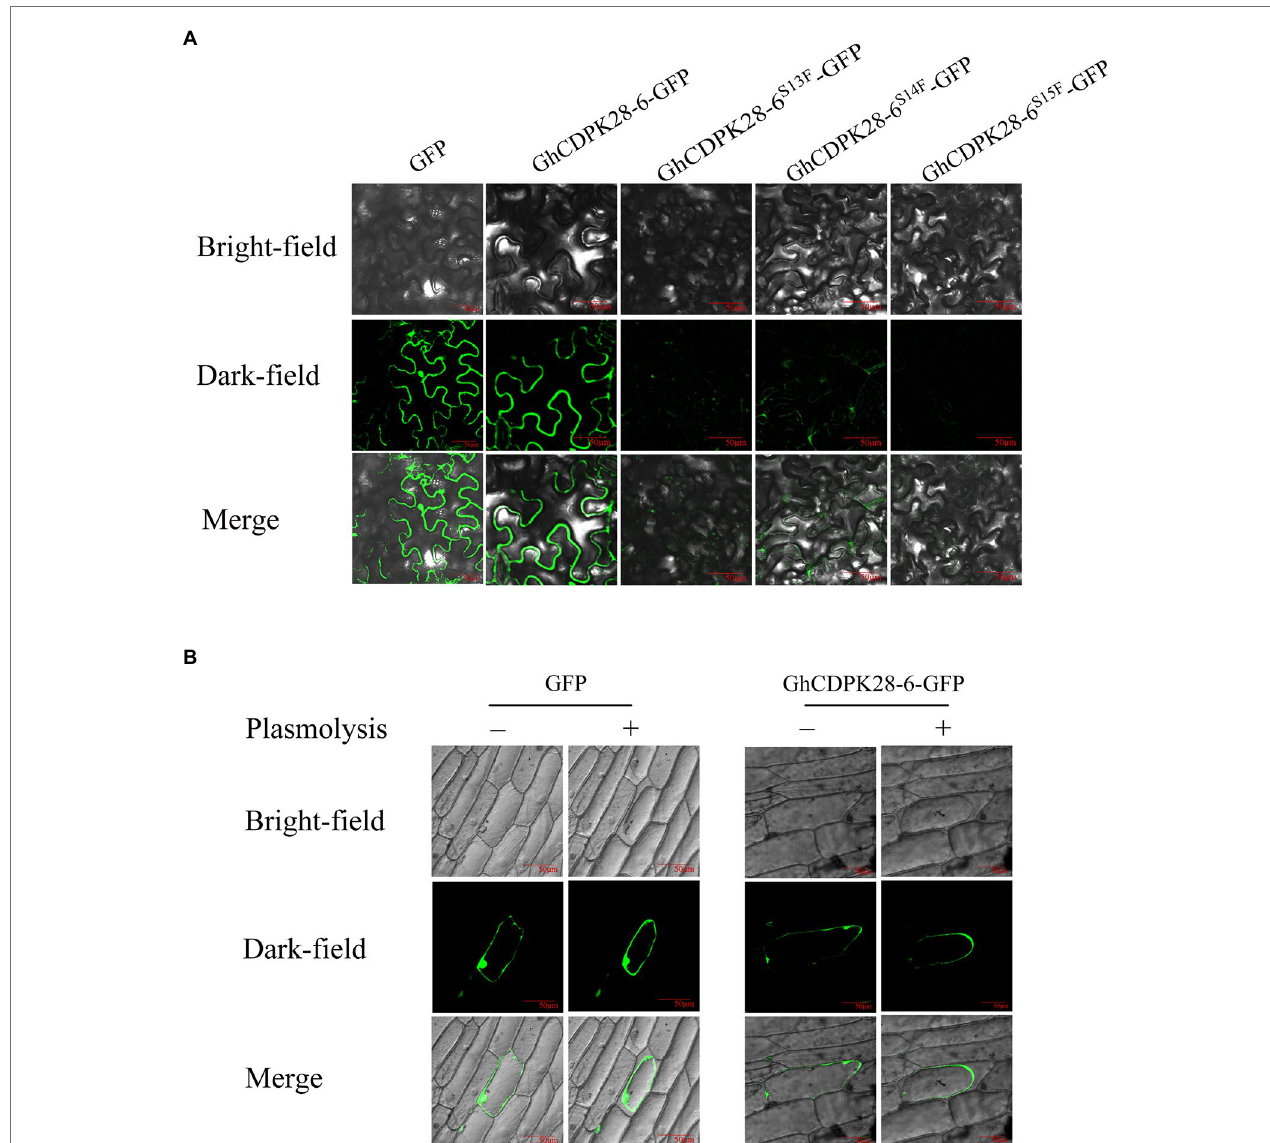
FIGURE 9 | Subcellular localization of GhCDPK28-6, GhCDPK28-6 S13F , GhCDPK28-6 S14F and GhCDPK28-6 S15F . (A) Subcellular localization of GhCDPK28-6, GhCDPK28-6 S13F , GhCDPK28-6 S14F and GhCDPK28-6 S15F in Nicotiana benthamiana . (B) Subcellular localization of GhCDPK28-6 in onion. In the plasma wall separation experiment, cells were treated with 20%